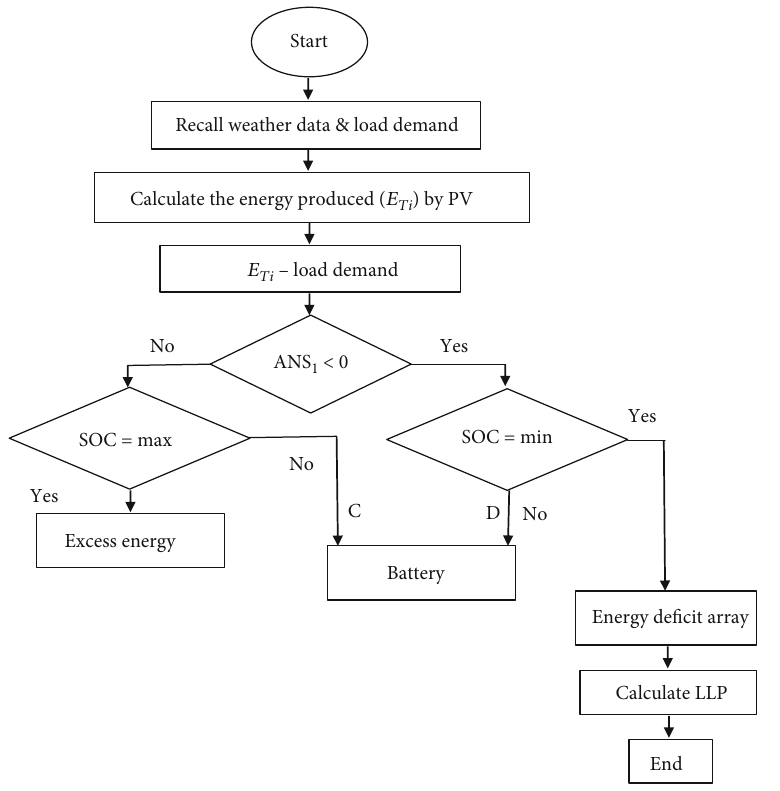
Figure 5: The adapted model for standalone PV system